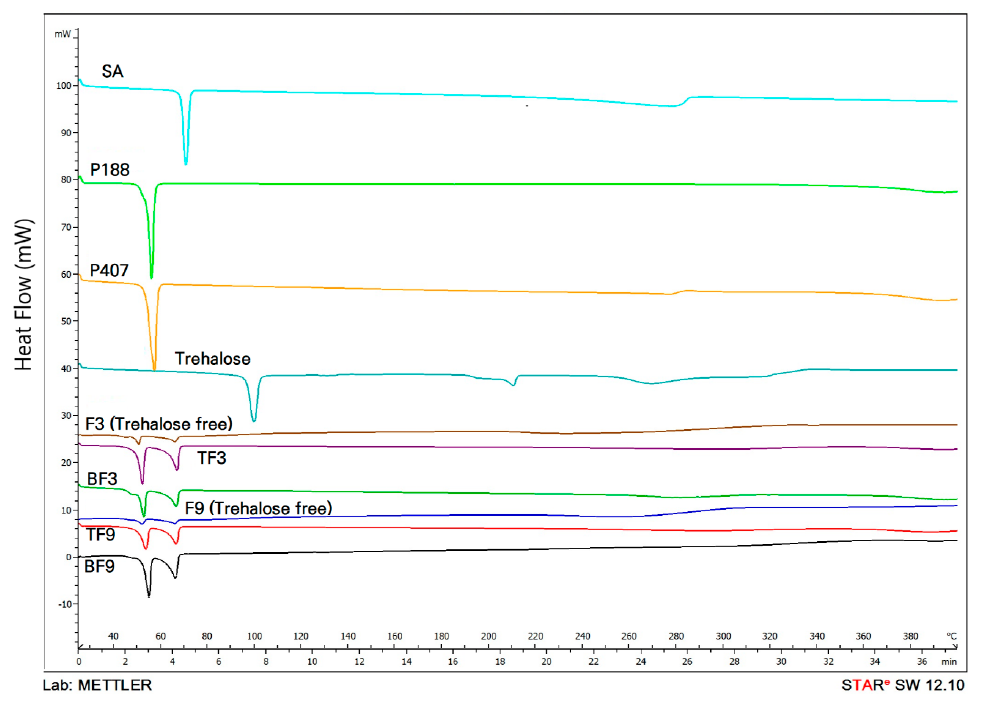
Figure 3. DSC thermograms of stearic acid (SA), poloxamer 188 (P188), poloxamer 407 (P407), trehalose, blank F3 (BF3), F3 (Trehalose free), trehalose added F3 (TF3), blank F9 (BF9), F9 (Trehalose free) and trehalose added F9 (TF9).